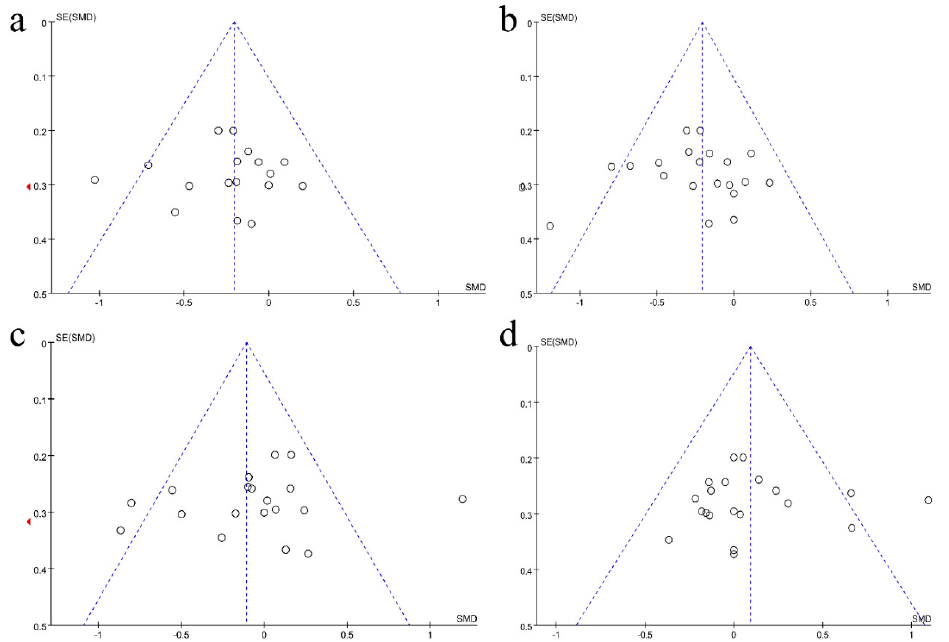
Figure 7. Funnel plots demonstrating publication bias in the included RCTs reporting the effects of probiotic intake on dyslipidemia. Note: Each dot represents a different study. ( a ) TC levels; ( b ) TG levels; ( c ) LDL-C levels; ( d ) HDL-C levels.